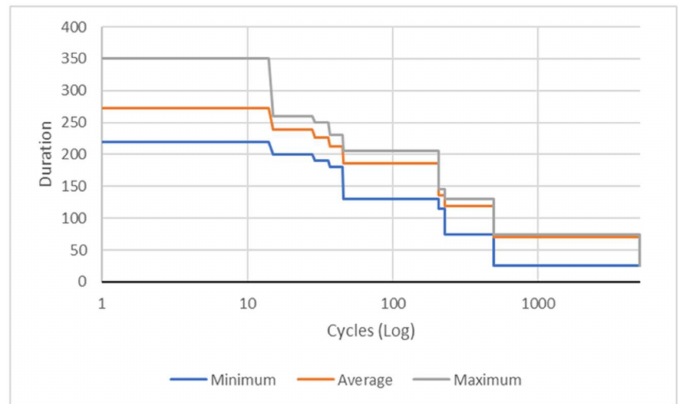
Figure 8. Typical run for Example 1 with seven walls: rectangular